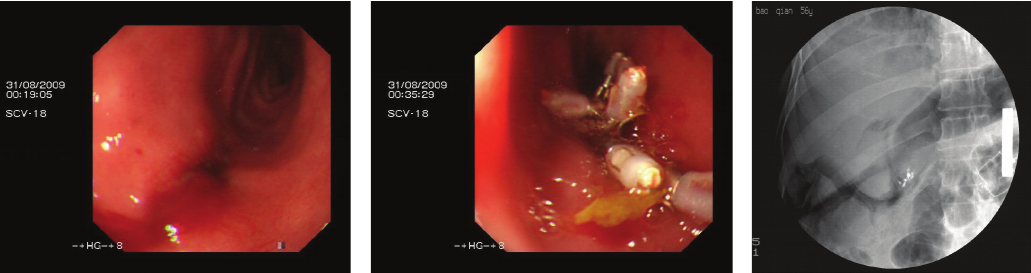
Figure 4: The duodenal lateral perforation was sutured by clips. The gas in peritoneal cavity was shown by